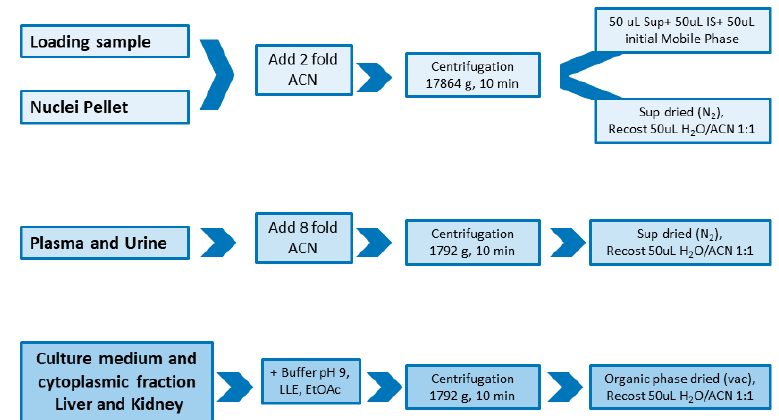
Figure 1. Graphical overview of sample purification and extraction methods applied to all bio-matrices.